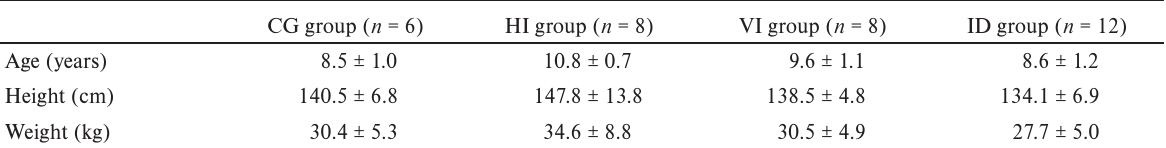
Mean age, height and weight of